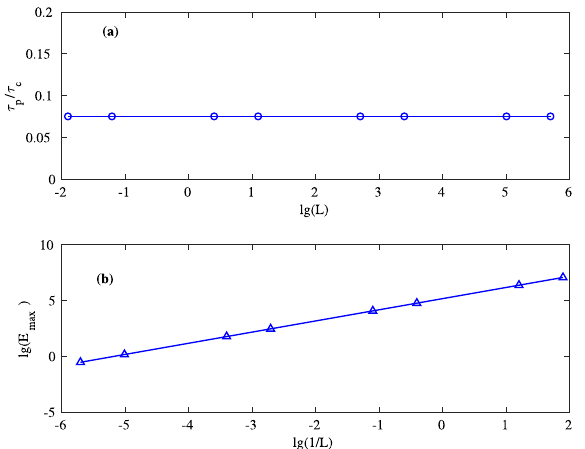
Figure 10. ( a ) Dependence of the pulse duration τ p normalized to the cavity round-trip time τ c on the cavity length in log scale. ( b ) Dependence of the pulse maximum on the inverse cavity length. This figure was created with Matlab R2016b (http://www.mathw